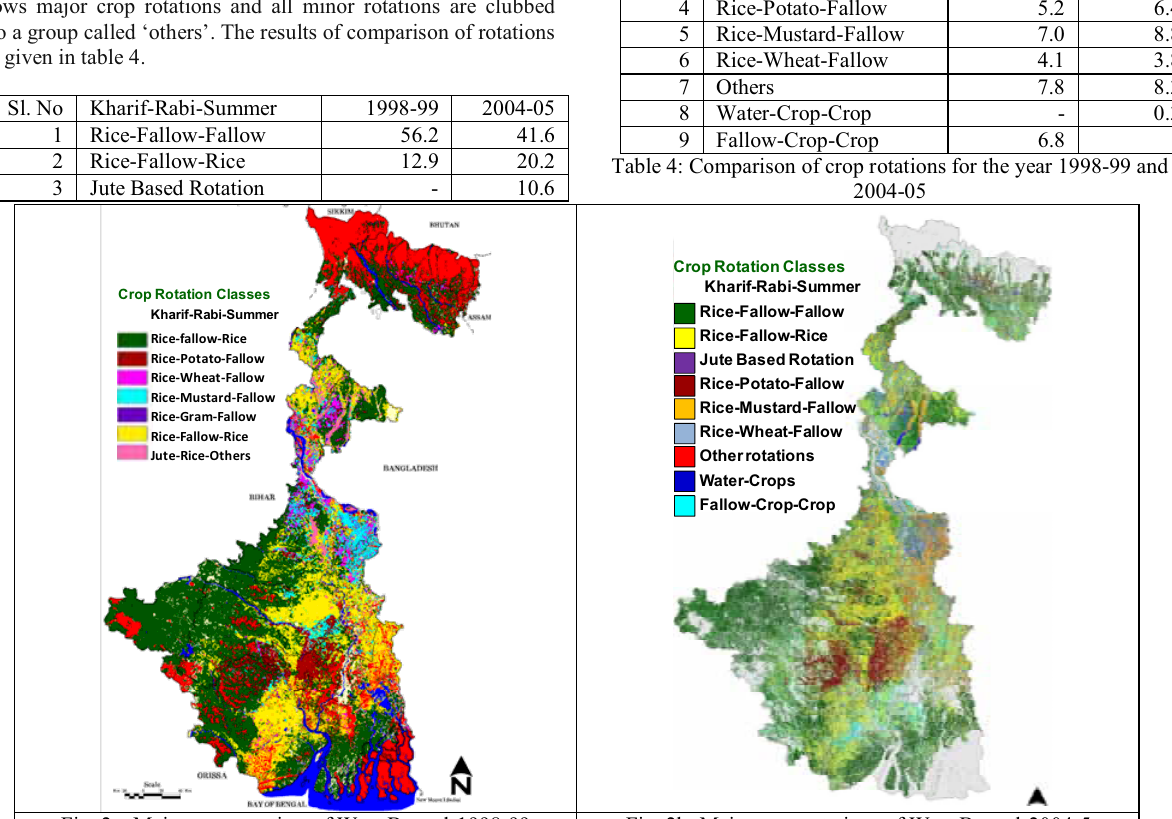
Fig. 2a: Major crop rotationsof West Bengal-1998-99 Fig. 2b: Major crop rotations of West Bengal-2004-5